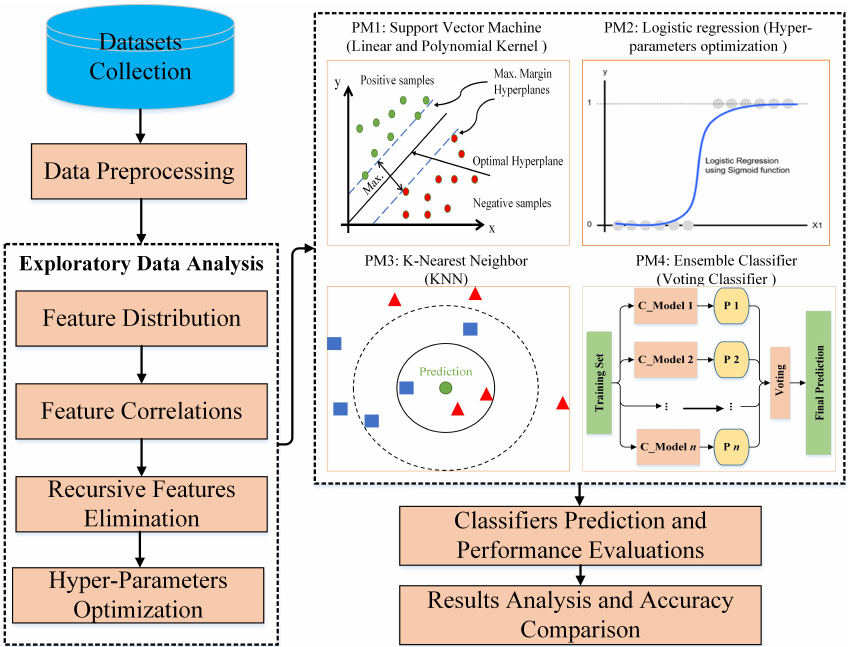
Figure 1. Schematic workflow diagram of our proposed method of breast cancer prediction with data exploratory techniques with machine learning